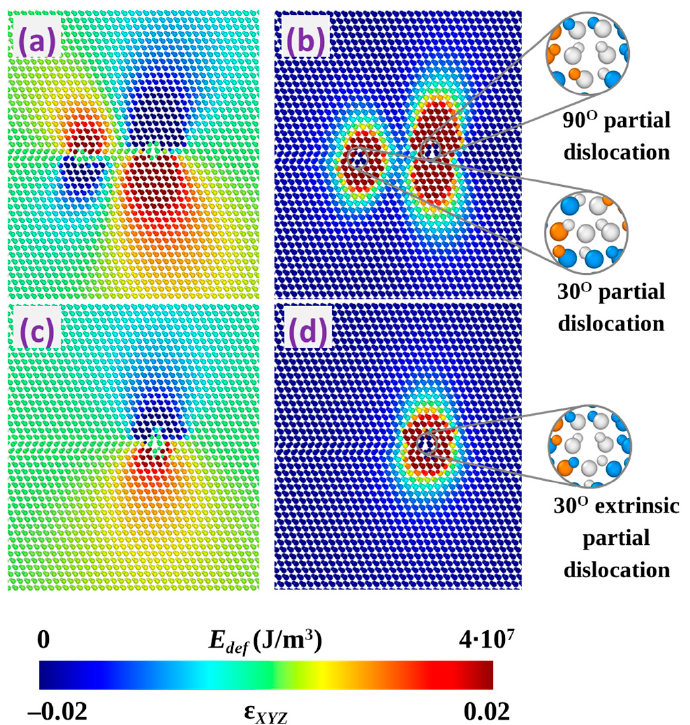
Figure 7. Distribution of volumetric strain ( a , c ) and elastic energy density ( b , d ) in 3C-SiC cell introduced by separated 30 ◦ and 90 ◦ partial dislocations located in consecutive [ 111 ] lattice planes (a , b) and 30 ◦ extrinsic partial dislocation formed as a result of their interaction ( c , d ).